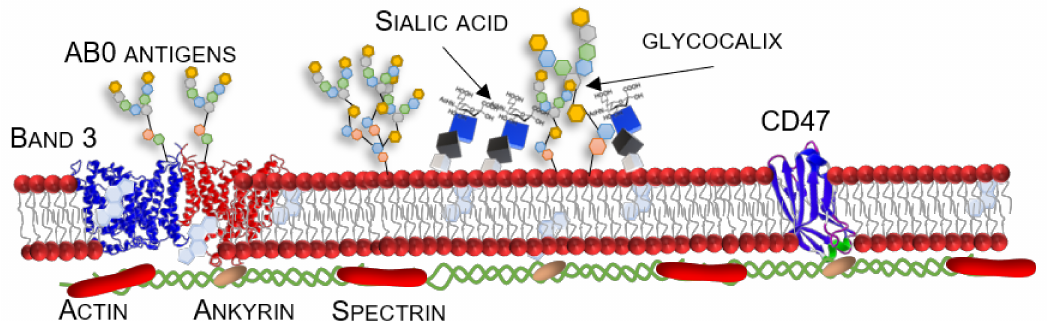
Figure 2. Native erythrocytes and ghosts are features that must be taken in account while developing a drug carrier. Band 3 protein (4YZF [88]), a bicarbonate/chloride ion exchanger, in contact with cytoskeleton via ankyrin, shows on its surface the AB0 antigen glycans; glycocalyx also comprises sialic acid, a phagocytosis mediator or inhibitor; CD47 (2JJS, [84]) is an ubiquitous integral protein that acts as a switch for macrophages phagocytosis interacting with a SIRP α